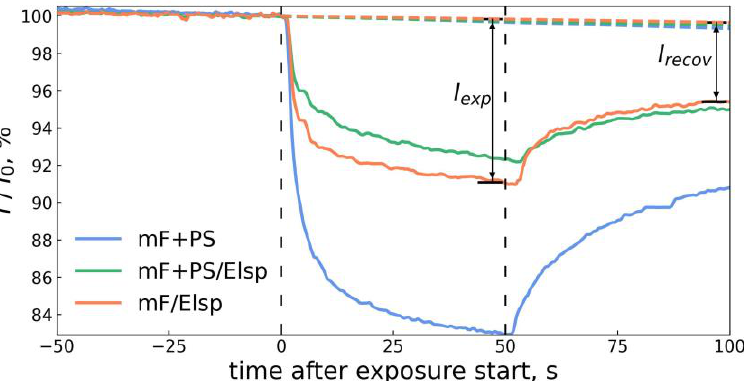
Figure 10. The recording of fluorescence responses of obtained sensor materials towards 160 mL of saturated vapor of nitrobenzene and the example of metrics I exp and I recov used to quantify fluorescent response of the material.